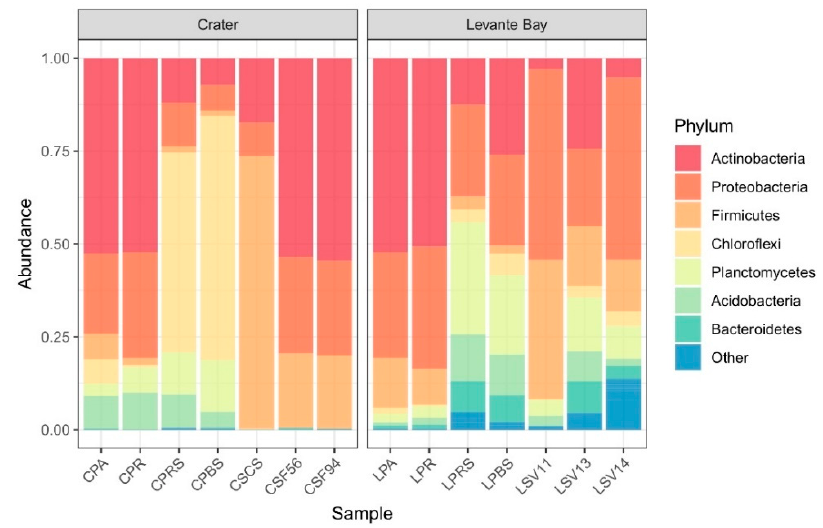
Figure 2. Bar plot showing the relative abundances of bacterial phyla in each sample (from Crater, on the left, and Levante Bay, on the right). Amplicon sequence variants (ASVs) representing < 3% of the whole community were reported as “Other”.